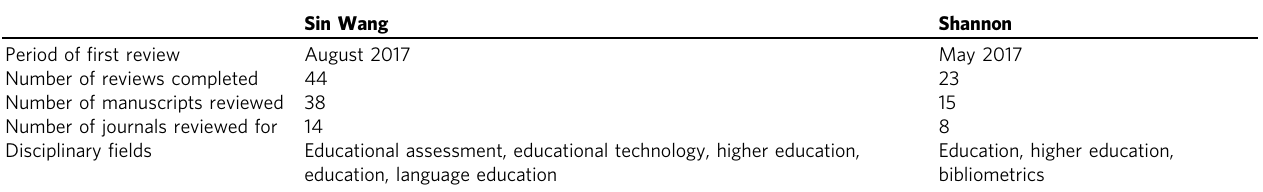
Table 1 Participants ’ experiences of peer review at the time of data